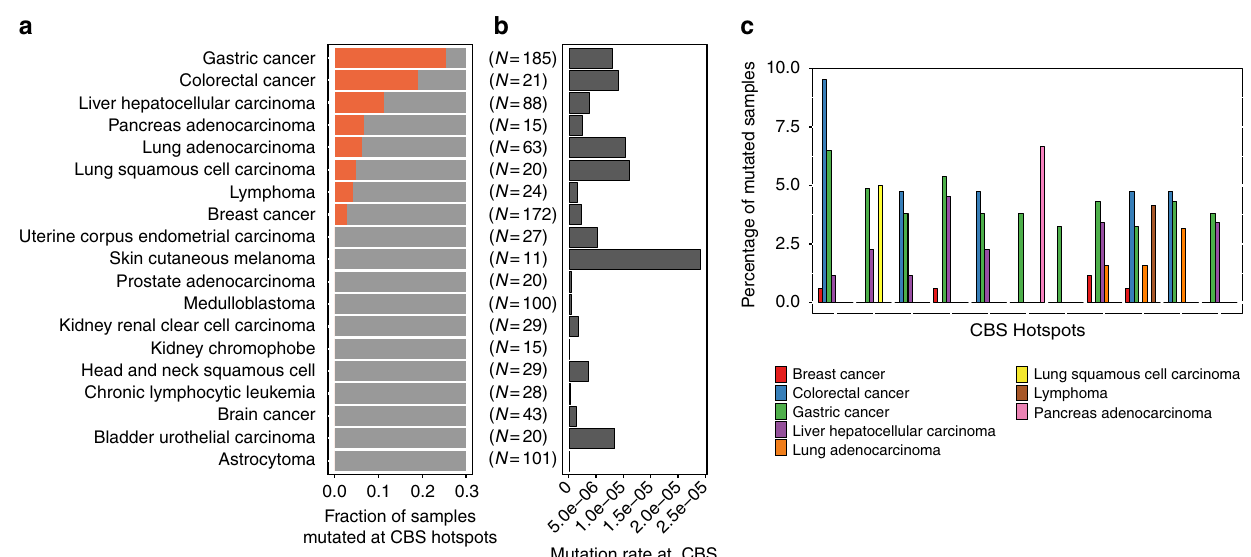
Fig. 6 Pan-cancer analysis of mutation recurrence at the 11 CBS mutation hotspots. a Fraction of samples with mutation in at least one of the CBS hotspots in different cancer types. b Mutation rate of CBSs in different cancer types. c Mutation recurrence of individual CBS hotspots in different cancer